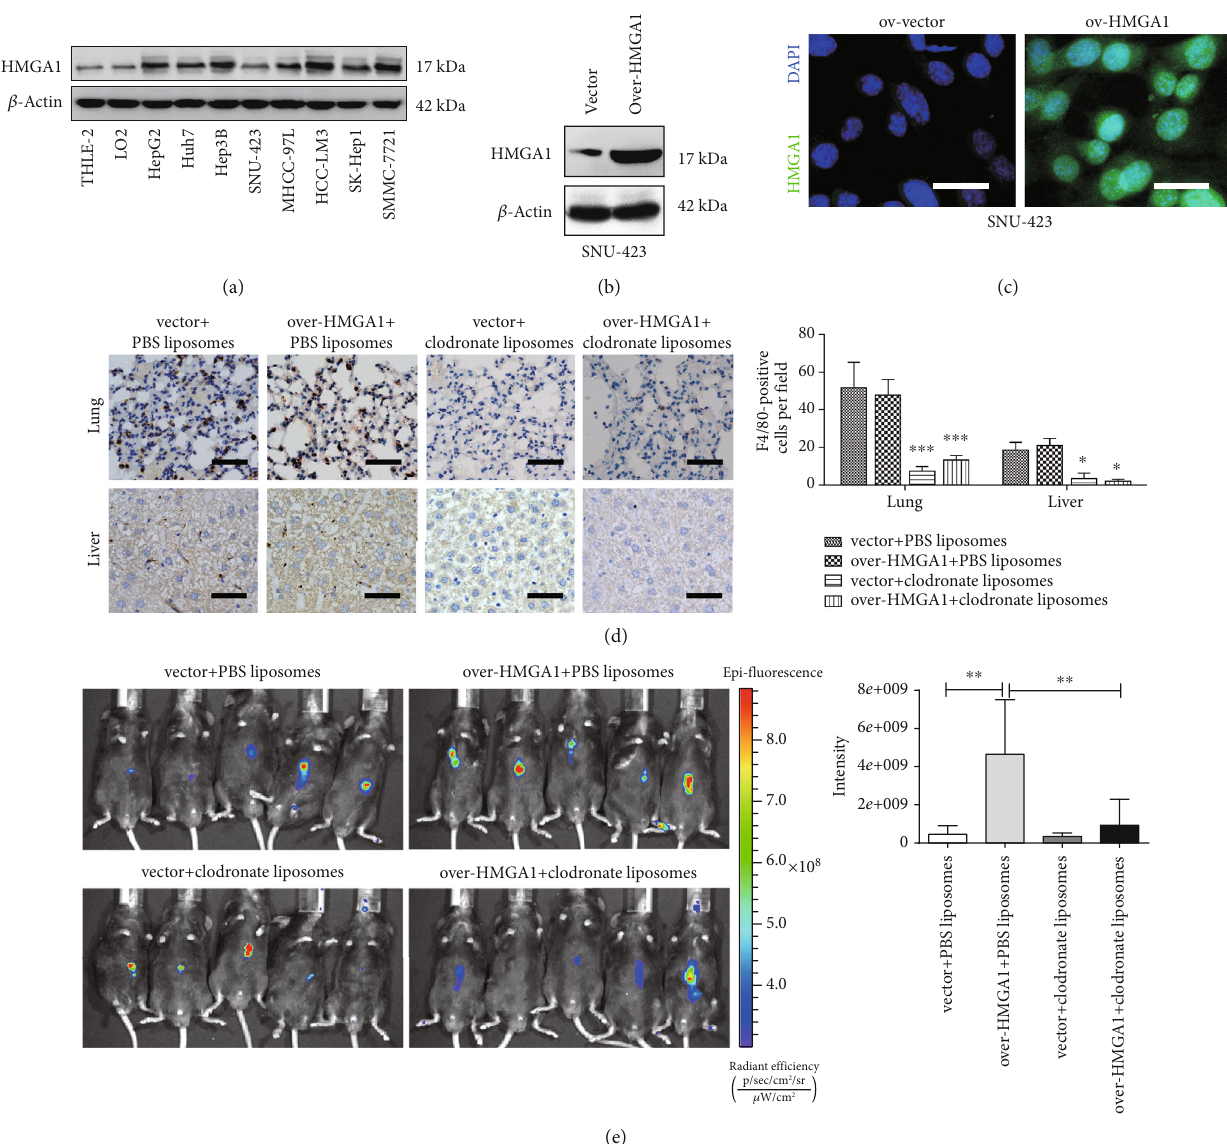
Figure 2: Depletion of macrophage mitigates HMGA1-induced tumor growth in HCC. (a) Western blotting analysis showed the protein level of HMGA1 in eight liver cancer cell lines and two normal control cell lines (LO2 and THLE-2). (b) SUN-423 cells were transfected with ov-HMGA1 or empty vector lentivirus, and Western blotting analysis showed the protein level of HMGA1 in ov-vector and ov- HMGA1 SUN-423 cells. (c) Immuno fl uorescence analysis showed the protein level and distribution of HMGA1 in ov-vector and ov- HMGA1 SUN-423 cells; scale bar: 10 μ m. (d) An orthotopic xenograft model was generated to determine the in vivo e ff ect of HMGA1 in HCC; immunohistochemical analysis was performed to investigate the F4/80-positive cells in liver and lung tissues obtained from C57BL/6J mice treated with either clodronate liposomes or PBS liposomes; scale bar: 50 μ m. ( e ) In vivo imaging analysis of tumors from the ov-vector, ov-HMGA1, ov-vector plus macrophage deletion, and ov-HMGA1 plus macrophage deletion groups ( n = 5 per group). The ANOVA followed by post hoc Tukey ’ s multiple comparison test was used for group comparisons. ∗ P < 0 : 05 ; ∗∗ P < 0 : 01 ; ∗∗∗ P < 0 : 001